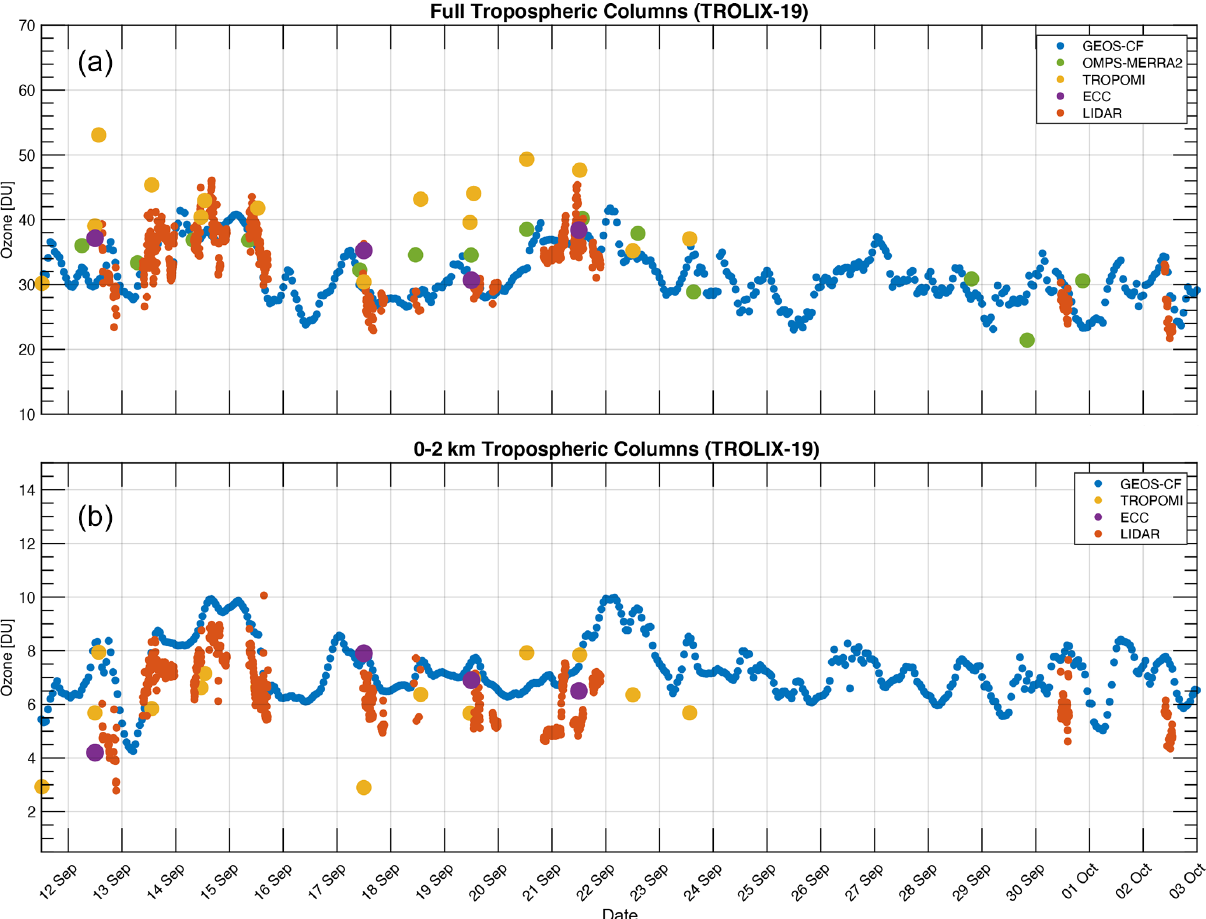
Figure 4. Full tropospheric columns (a) and 0–2km tropospheric columns (b) calculated from GEOS-CF, OMPS-MERRA2 (full column only), TROPOMI, lidar and ECC. Data where reflectivity was greater than 0.6 were excluded to remove cloud